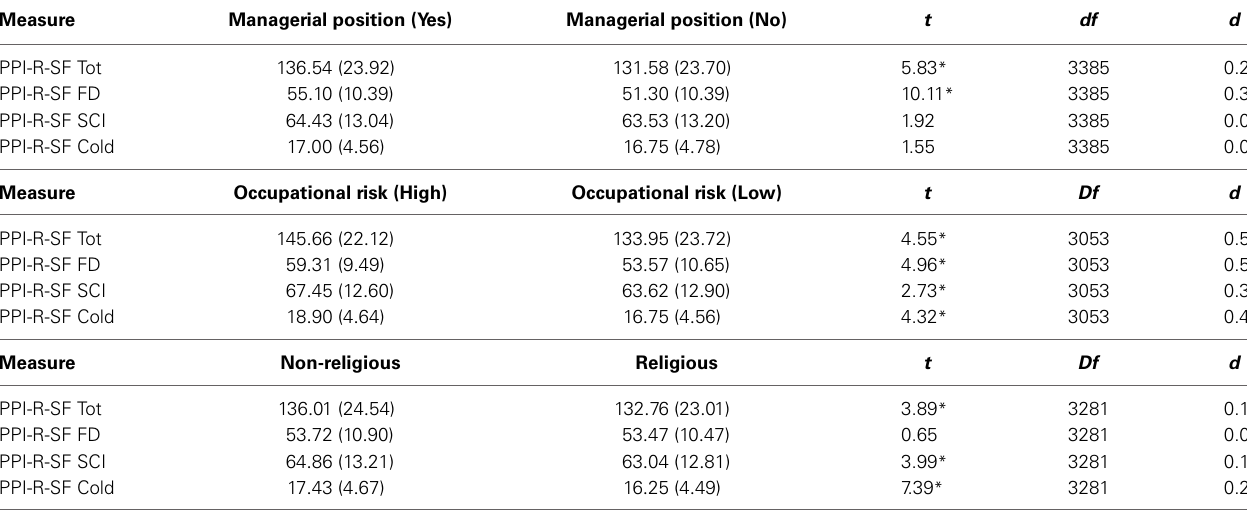
Table 3 | Group comparisons for managerial status, high-risk occupational status, and religious